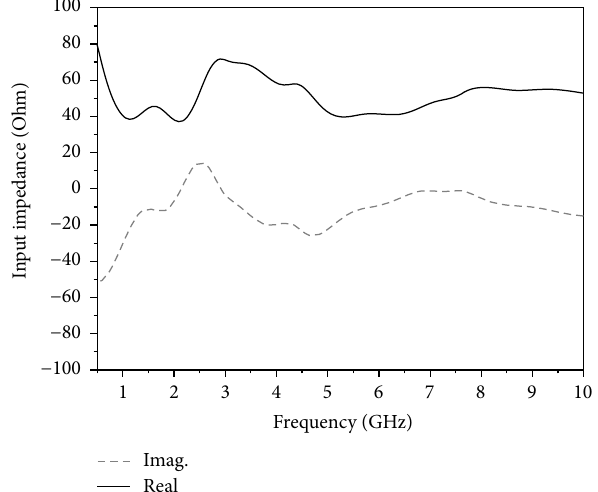
Figure 7: Simulated input impedance of proposed antenna.